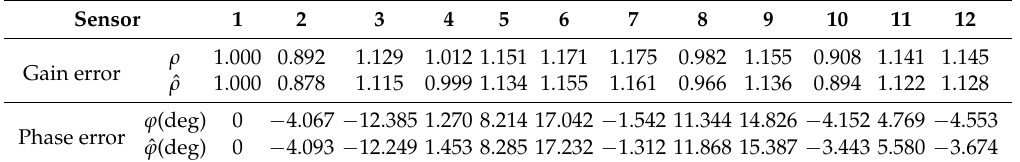
Table 1. Theoretical and average estimated values of the gain and phase errors for 12 sensors.